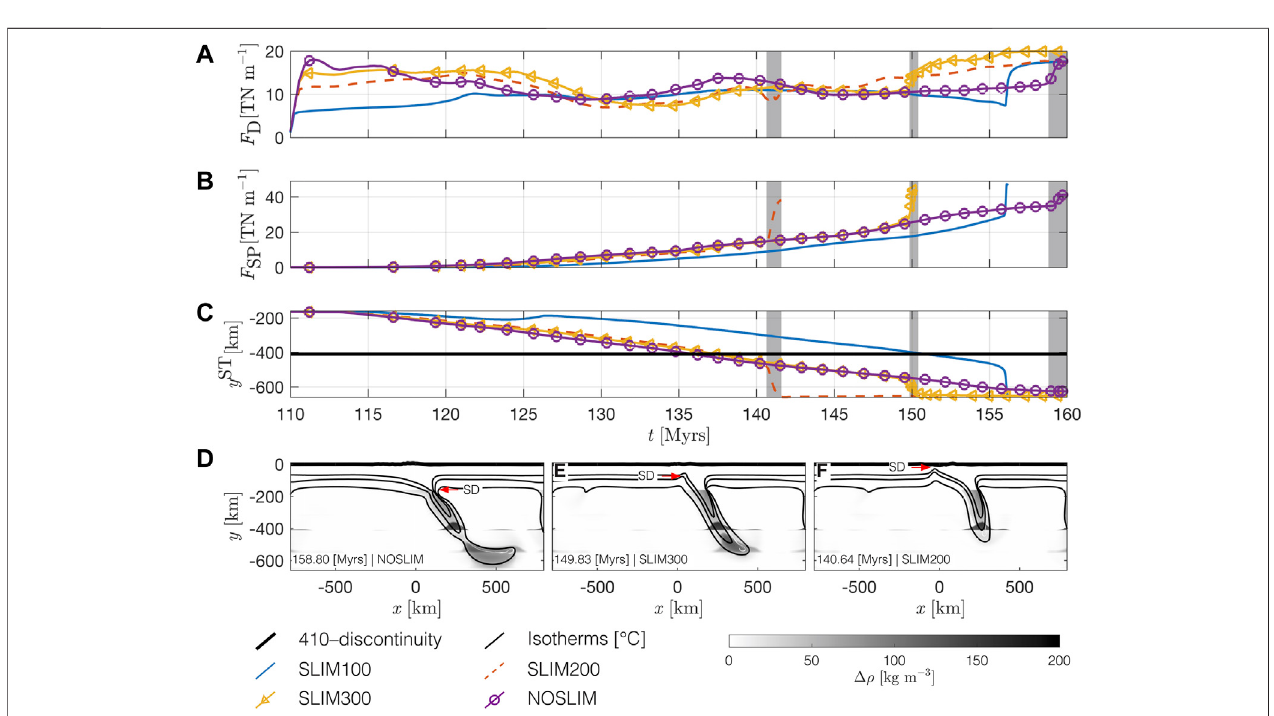
FIGURE8| Evolutionof (A) horizontaldrivingforces, F D ,and (B) theslabpullforce, F SP .Panel (C) showsthedepthoftheslabtipovertimeandpanels (D – F) show the difference between the local mantle density and an average vertical mantle density pro fi le, Δ ρ , at the onset of necking in the subducting slab for three different stress limiters.Greyrectanglesinpanels (A – C) marktheperiodfromneckingofthesubductingslabtoitsdetachment.Comparedtoastrongplate[nostresslimit, (D) ],necking is induced soon after the slab tip transects the 410-discontinuity [see panel (C) ] for a weak plate [low stress limit, (F) ].